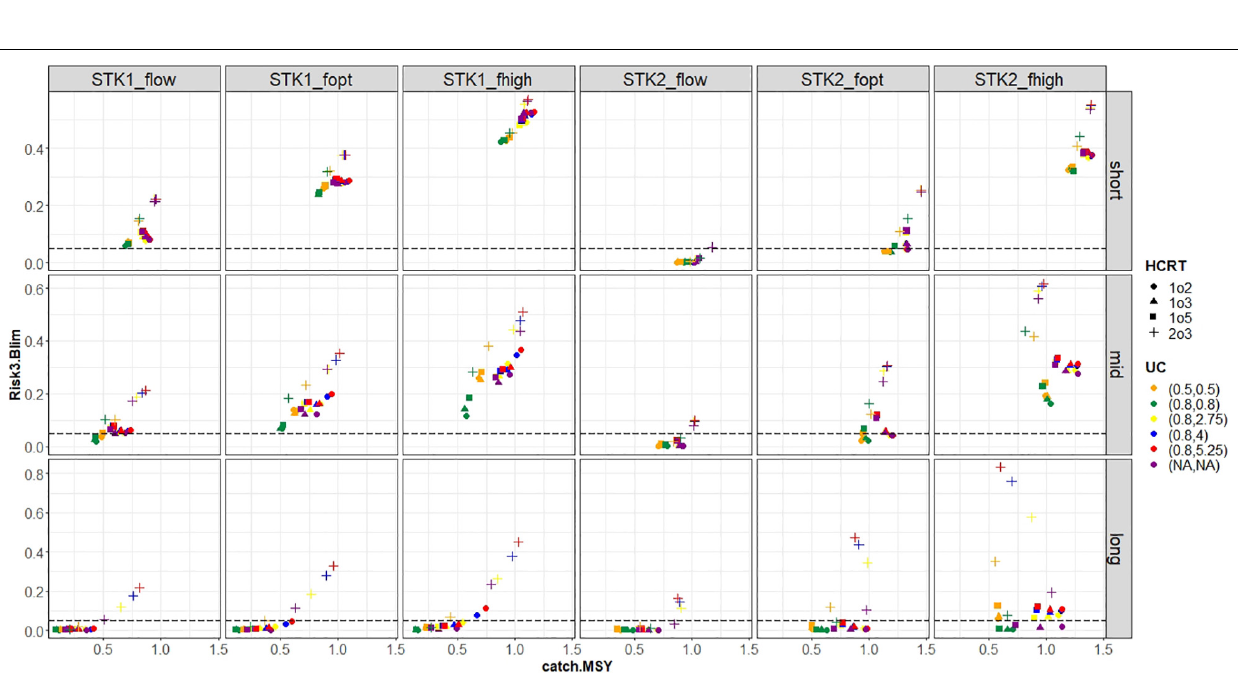
Frontiers in Marine Science |